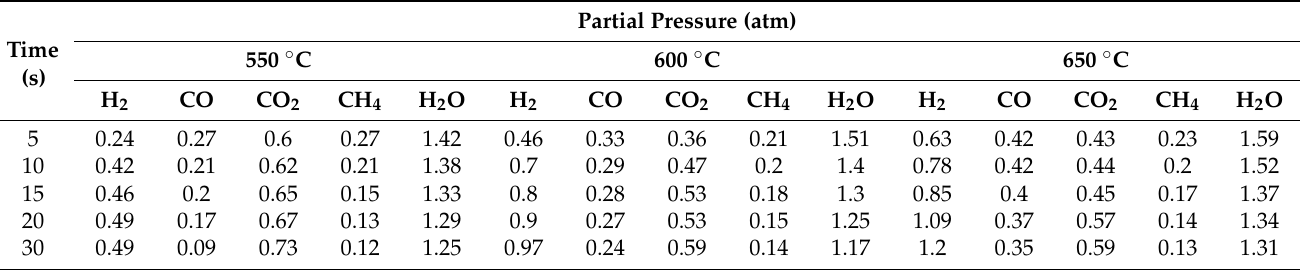
Table 4. Experimental partial pressures of the compounds obtained during the experiments with the catalyst 5% Ni–0.25%